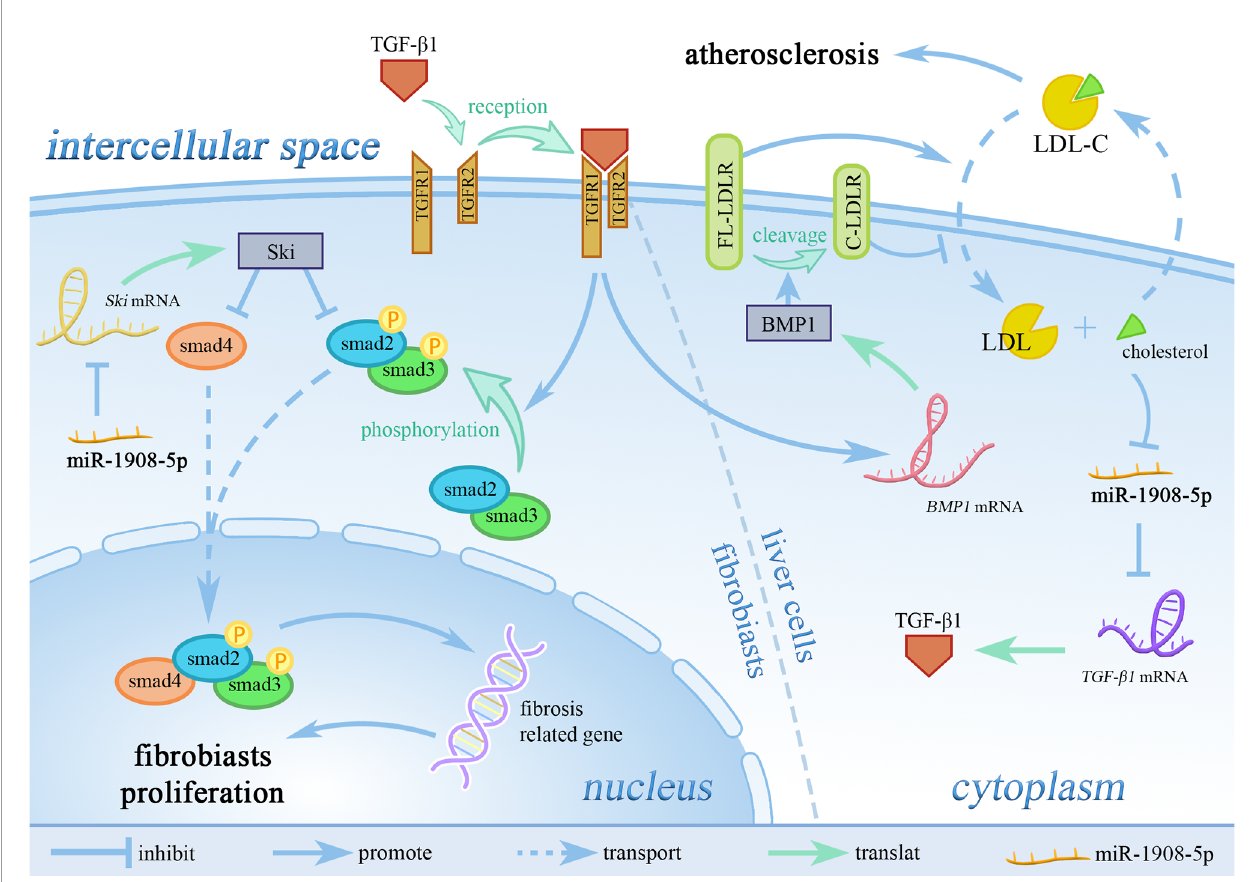
FIGURE 5 | miR-1908-5p regulates LDL-C metabolism in blood through the TGF- b 1 signaling pathway. TGFR1, TGF receptor 1; TGFR2, TGF receptor 2; LDL-C, low-density lipoprotein cholesterol; FL-LDLR, full-length LDL receptor; C-LDLR, cleaved LDL receptor. miR-1908-5p plays an pivotal role in the process of organ and tissue fi brosis and atherosclerosis by targeting TGF- b